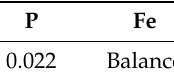
Table 1. Chemical composition of DIN1.5025 steel sheet. Alloying